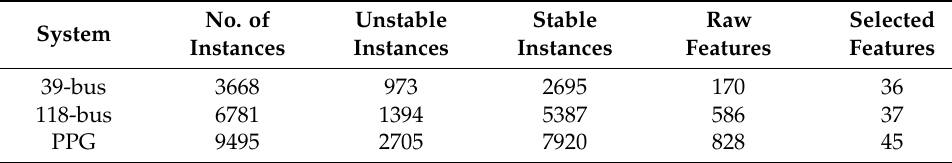
Table 1. Database of the three test